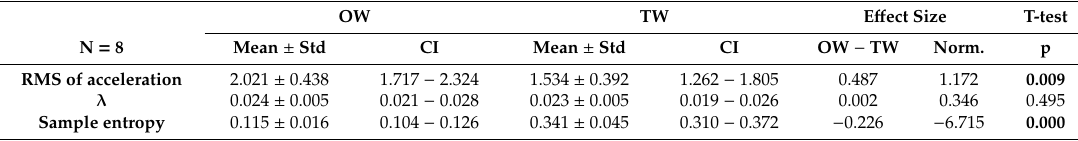
Table 5. Comparison of gait features during swing phase in V direction between TW and OW condition.